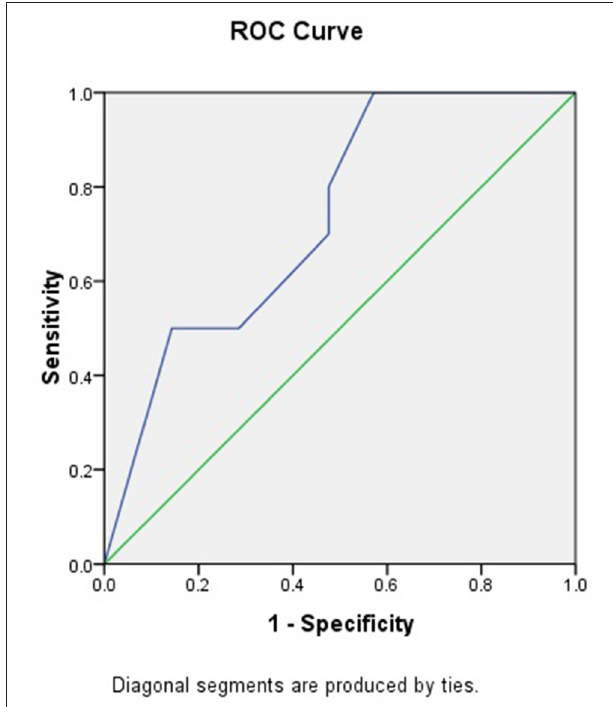
FIGURE 2 | ROC curve of SIJ–MRI bone erosion